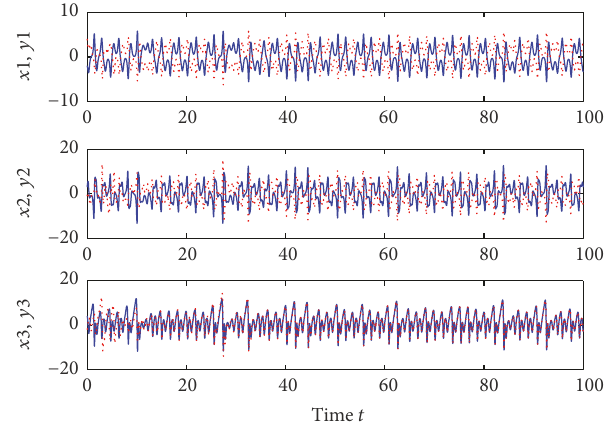
Figure 7: The figure shows that 𝑥 1 , 𝑥 2 antisynchronize 𝑦 1 ,𝑦 2 , while 𝑥 𝑦 3 synchronizes 3 ,